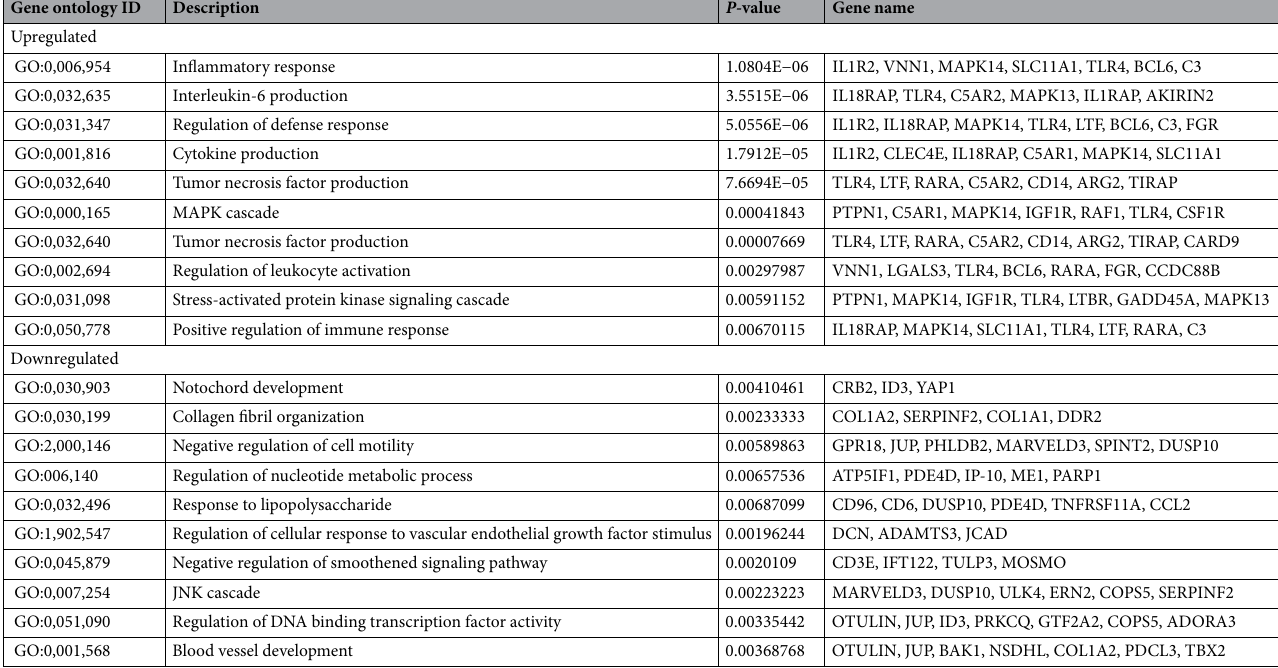
Table 6. Upregulated and downregulated biological processes in blood samples of goats transported for 180 min vs. goats not transported